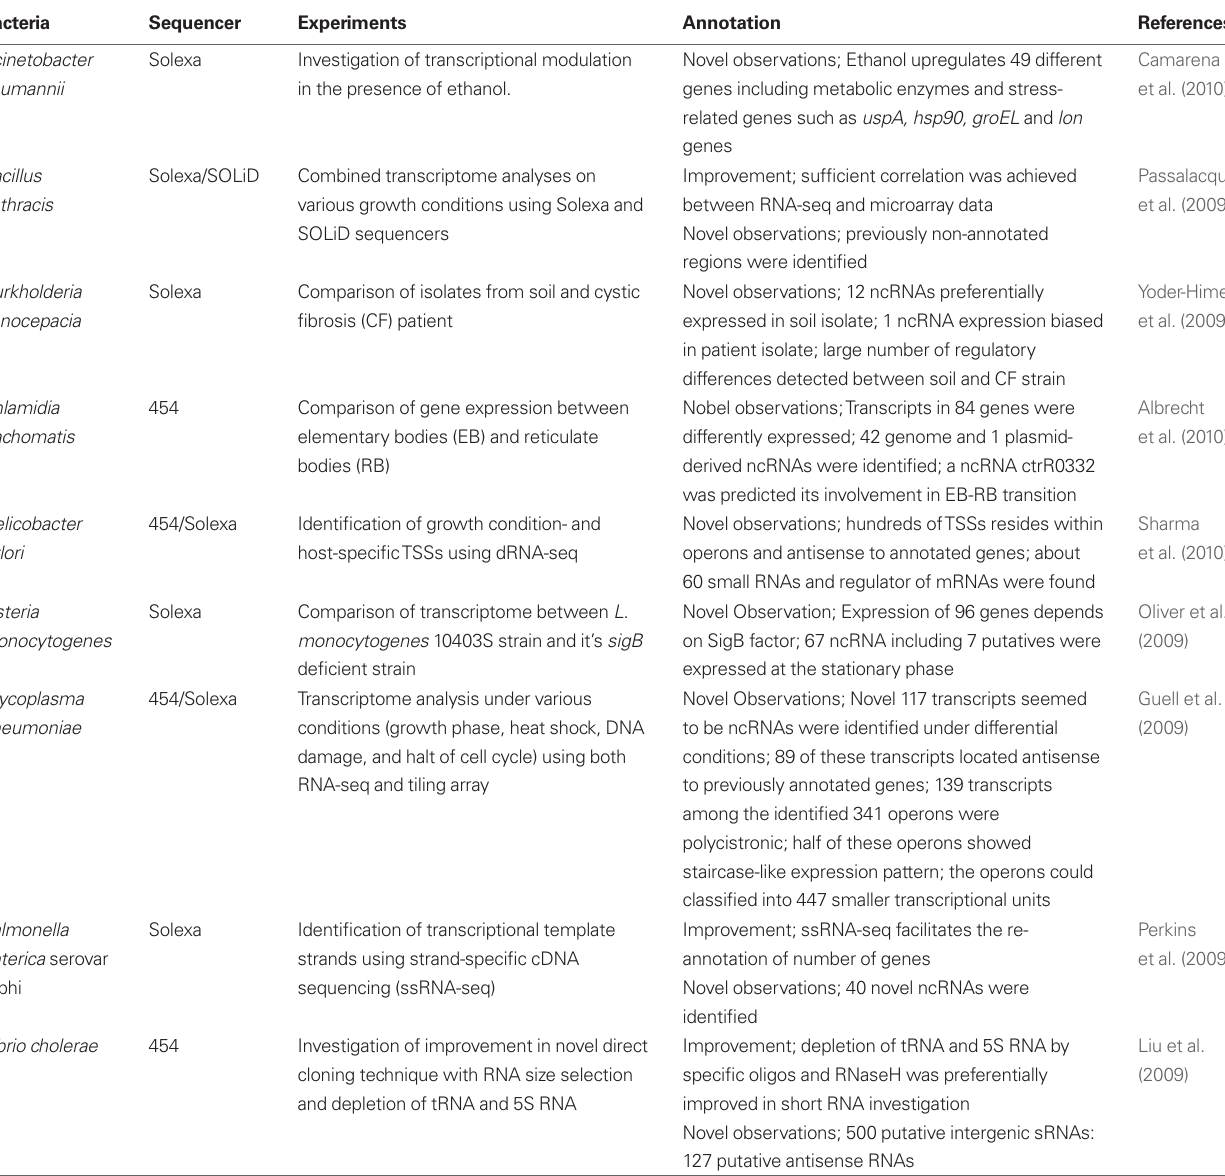
Table 2 | Bacterial transcriptome analyses using massively parallel